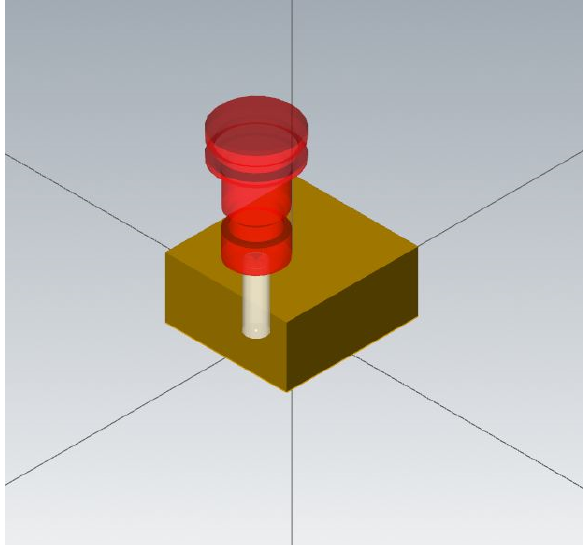
Figure 7. Computer Model Simulation—Virtual Reality.